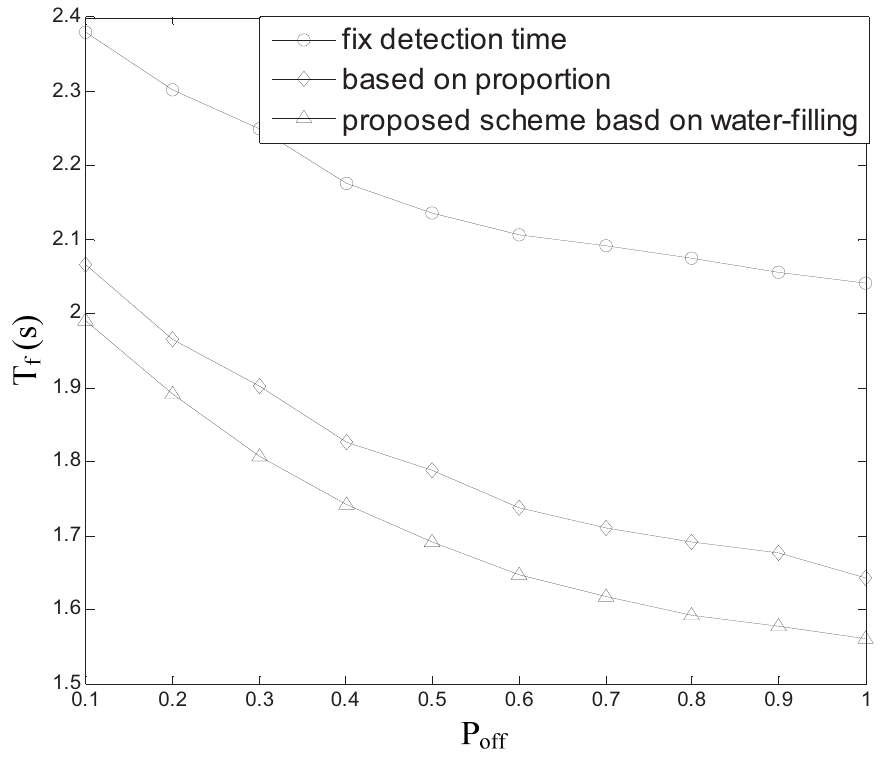
Figure 11. Average searching time vs. average idle